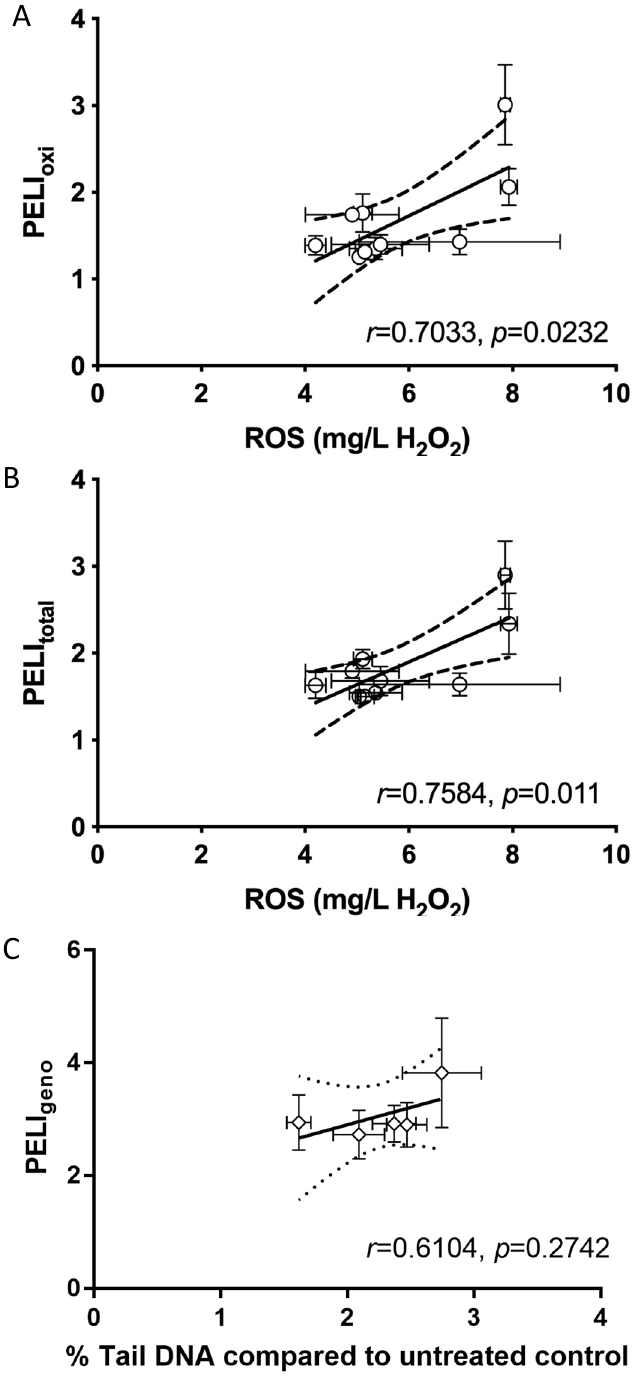
Figure 5. Correlation of intracellular ROS generation (equivalent to mg/L H 2 O 2 ) with PELI oxi ( A ) and PELI total ( B ) in yeast, and correlation of % Tail DNA compared to the untreated control with PELI geno ( C ) for the 5 tested graphene oxides (GOs). The % Tail DNA compared to the untreated control examined by the alkaline comet assay indicates DNA damage caused in human A549 cells by the 5 GOs. The 95% confidence intervals are indicated by the dash lines. ( A ) and ( B ): x -axis bottom: ROS production in yeast equivalent to mg/L H 2 O 2 ; y -axis: PELI oxi ( A ) or PELI total ( B ) in yeast assay. ( C ) X-axis bottom: % Tail DNA compared to untreated control; Y-axis: PELI geno in yeast assay. r indicates Pearson correlation coefficient; p value shows whether the correlation is significantly linear. Mean ± SD. For ROS production, n = 3; for comet assay, n = 4. An error bar was not shown when it was smaller than the marker size.